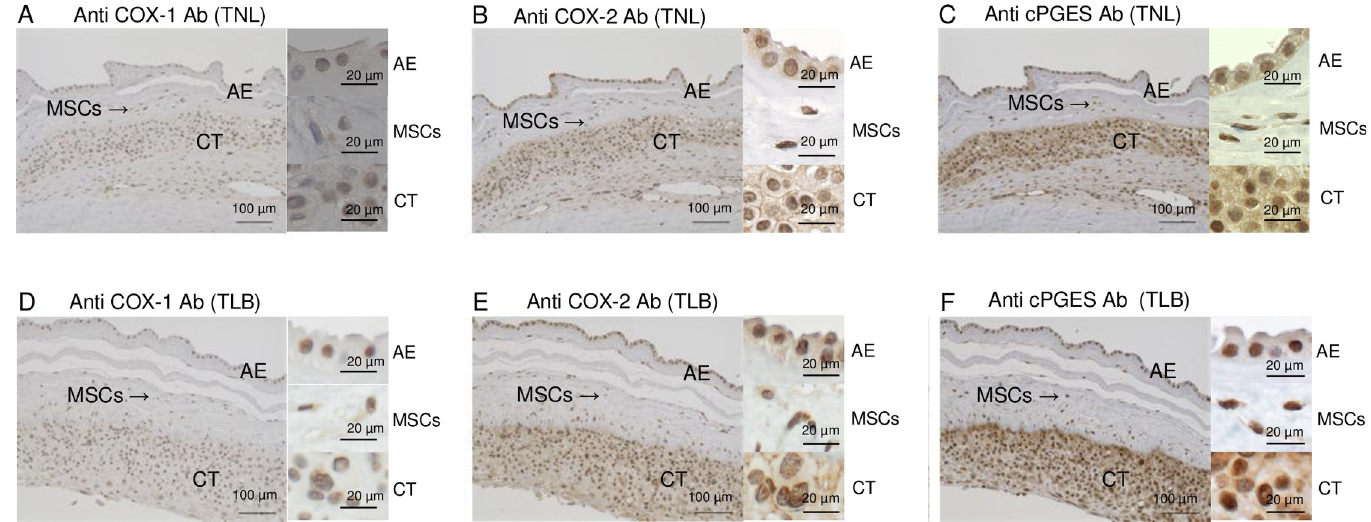
Fig 6. Immunohistochemical analyses of prostaglandin E 2 (PGE 2 ) biosynthetic enzymes proteins in fetal-membrane. Immunohistochemical staining of fetal- membrane with antibodies (Ab) specific for cyclooxygenase-1 (COX-1) (A, D), cyclooxygenase-2 (COX-2) (B, E), and cytosolic PGE synthase (cPGES) (C, F). Hematoxylin was used for nuclear counterstaining. Membrane sections were from patients with term not in labor (TNL; A–C) and term in labor (TLB; D–F) deliveries. Scale bars = 100 μ m (Left; low-power field), Scale bars = 20 μ m (Right: high-power field). AE, amniotic epithelium; MSCs, mesenchymal cells; CT, chorionic trophoblast.